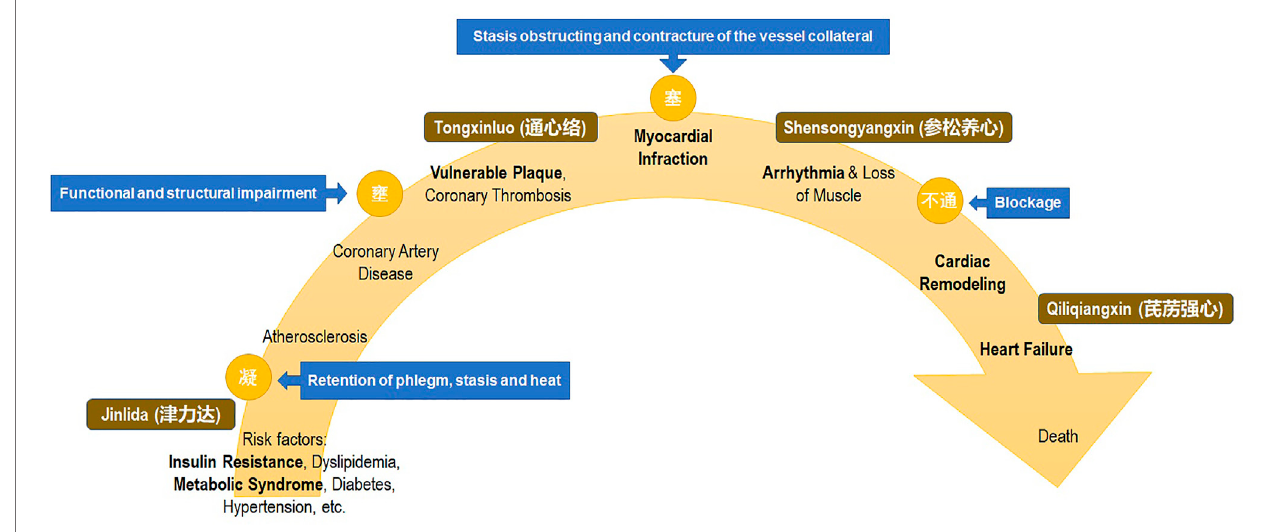
FIGURE 1 | Cardiovascular continuum and intervention with traditional Chinese medicine set prescription of collateral disease